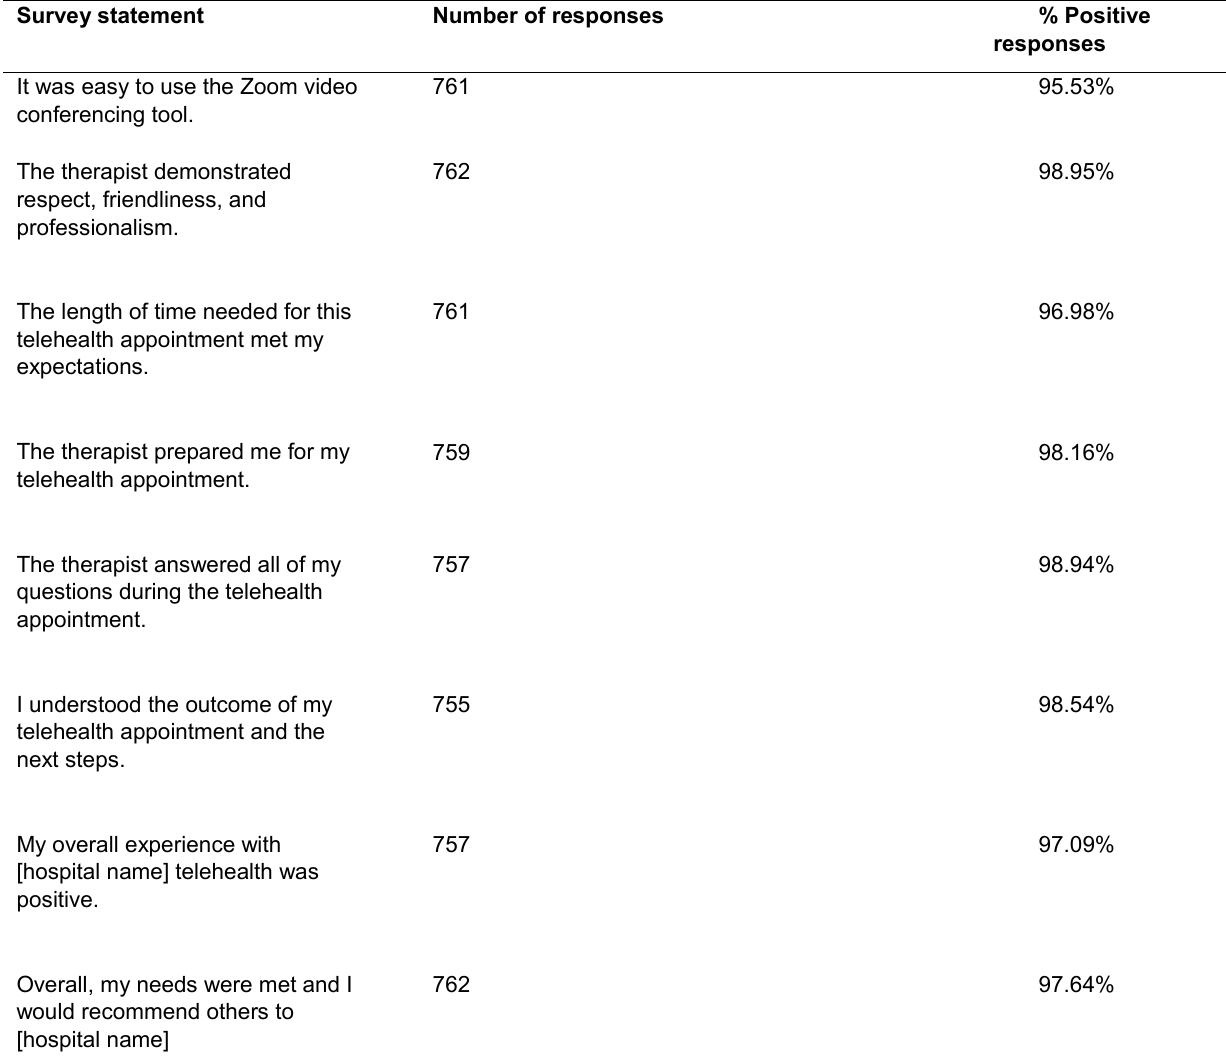
Telerehabilitation Patient Satisfaction Survey Results